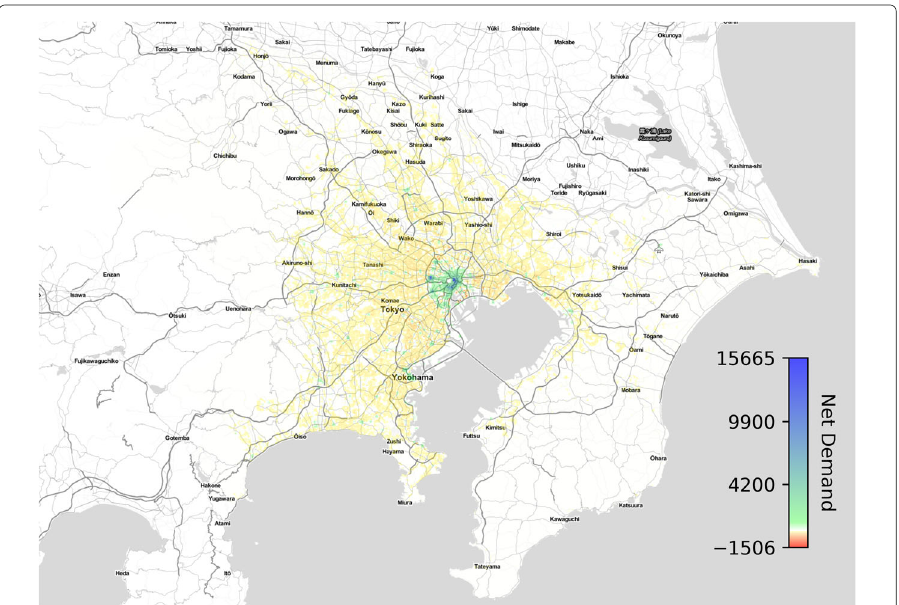
Fig. 7 A map of the Tokyo area showing the net demand for workers: number of jobs minus the working population for each hex. Map tiles by Stamen Design (2019), map data by OpenStreetMap(OpenStreetMap Contributors